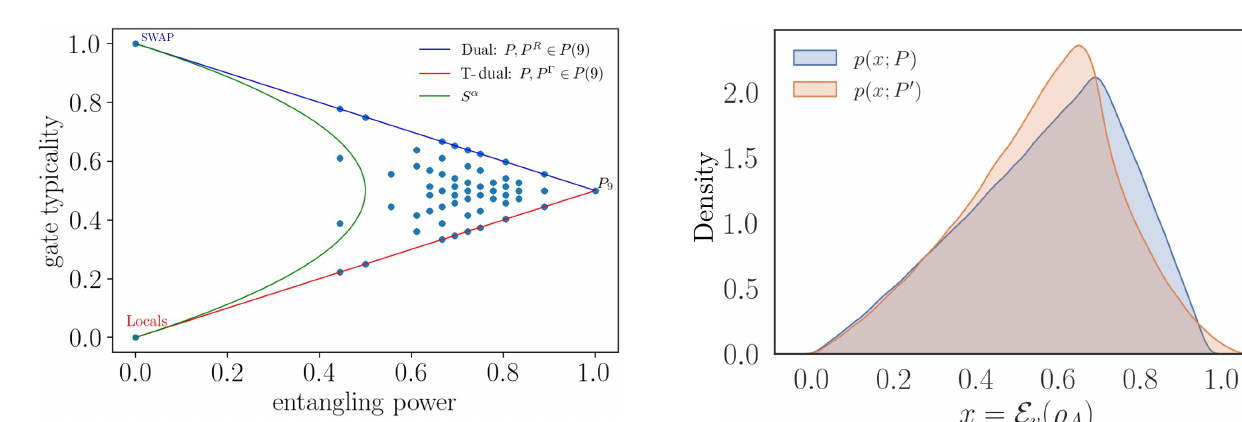
FIG. 11. The entanglement distributions obtained for P and P (cid:8) permutation matrices of size 9 belonging to two LUS classes (see the text) corresponding to the entangling class with e p ( U ) = 2 / 3. The distinguishabiliity of the distributions implies that P and P (cid:8) are not LU